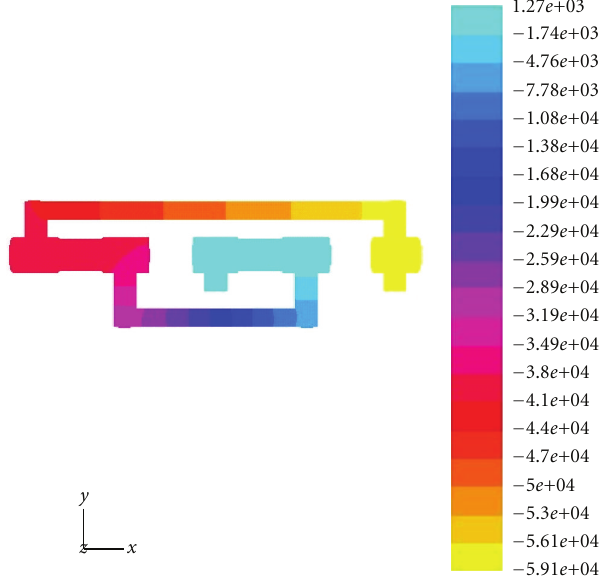
Figure 2: The distribution characteristics and change processes of turbulence kinetic energy in a high-pressure valve runner.